Question: What direction does the quantity move in — increasing or decreasing?
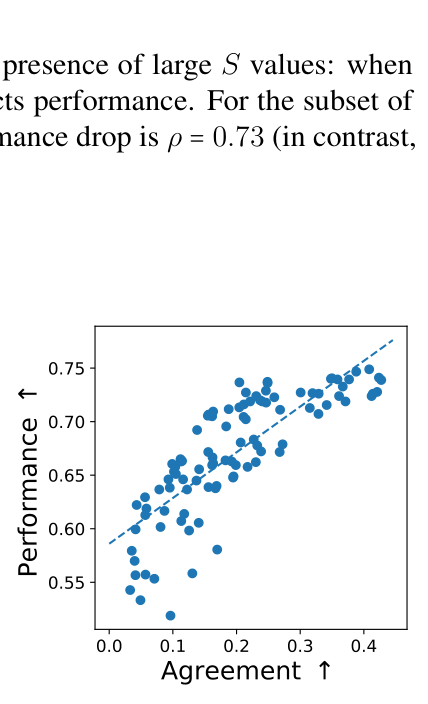
Answer: decreasing